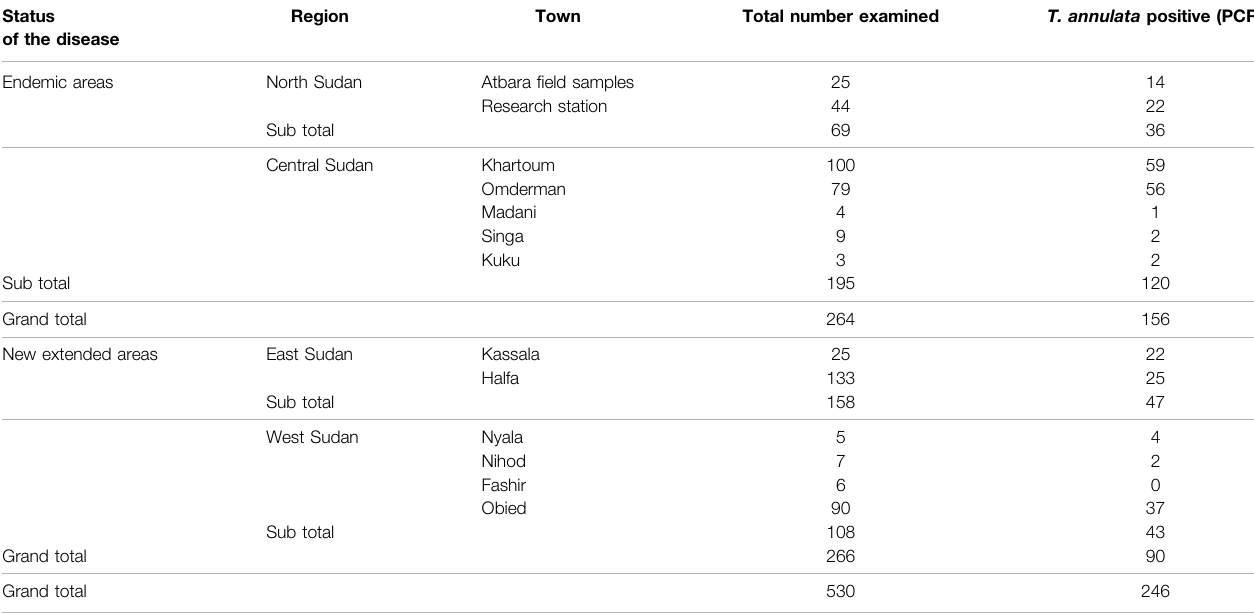
TABLE 1 | Information on sample numbers and